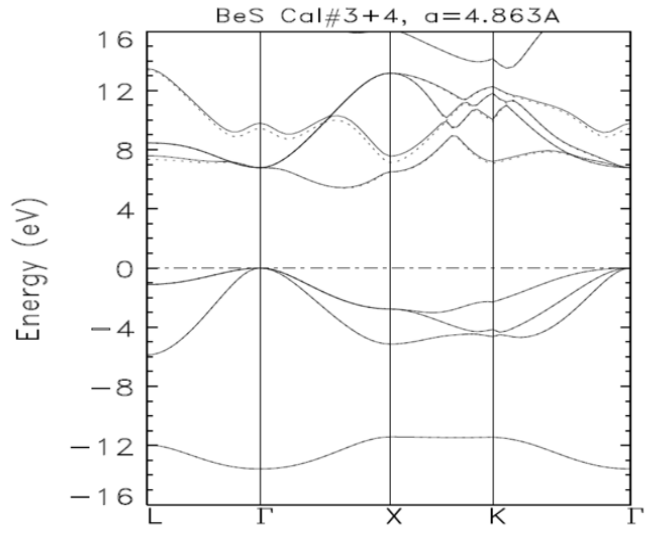
Figure 1. The electronic band structures of zb-BeS for a room temperature experimental lattice constant of 4.863 Å as obtained from calculations III (solid lines) and IV (dashed lines). Zero on the vertical axis denotes the position of the Fermi energy.